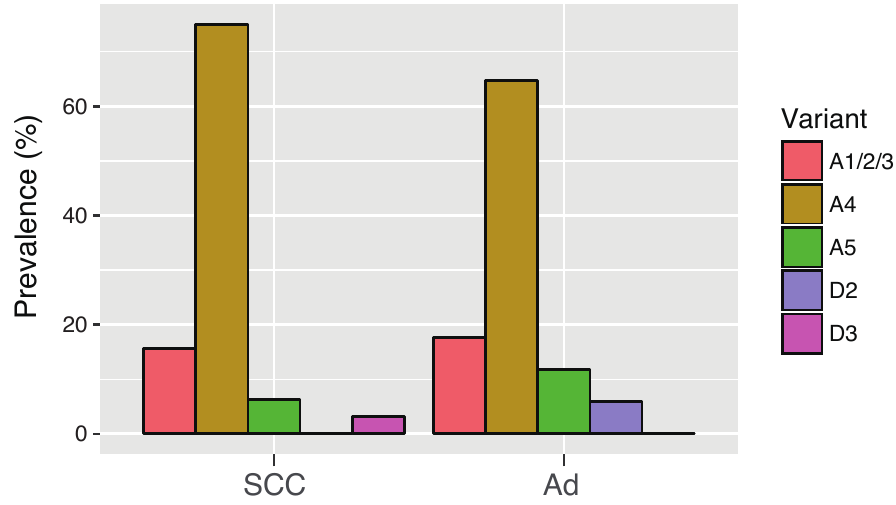
Figure 3. Distribution of HPV16 variant (sub) lineages in cervical squamous cell carcinoma and adenocarcinoma. HPV16 single-infection cases of squamous cell carcinoma (SCC) ( n = 32) and adenocarcinoma (Ad) ( n = 17) were classified into variant (sub) lineages. The prevalence of each (sub) lineage is shown as the percentage in the total number of cases in each